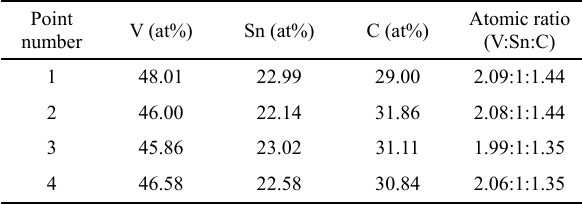
Table 3 Chemical compositions obtained from EDS analysis of V 2 SnC